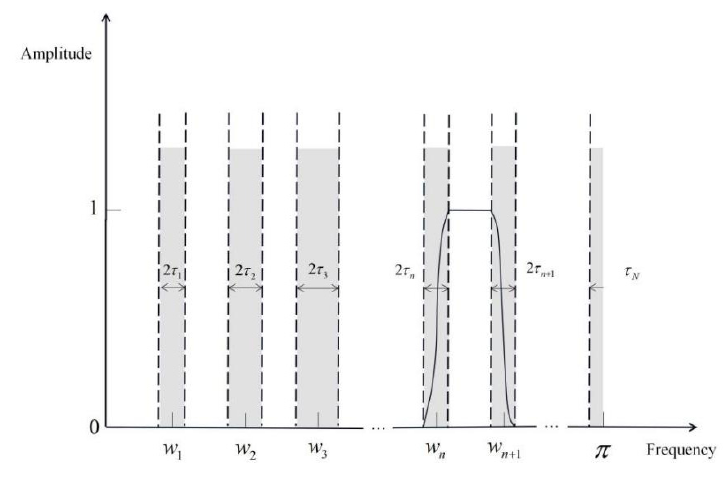
Figure 1. Fourier spectrum segmentation.